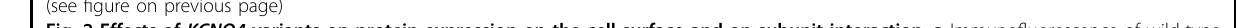
Fig. 2 Effects of KCNQ4 variants on protein expression on the cell surface and on subunit interaction. a Immuno fl uorescence of wild-type (WT) and variant KCNQ4 proteins in HEK 293 cells. Cells were immunostained with anti-Myc, anti-BiP, and anti-GOLGB1 antibodies. Nuclei were stained with DAPI. BiP and GOLGB1 indicate the endoplasmic reticulum and Golgi apparatus, respectively. All KCNQ4 variant proteins were observed on the plasma membrane. b Cell surface biotinylation. Proteins on the plasma membrane were labeled with biotin, isolated with avidin beads, and assessed by western blotting. Surface expression of KCNQ4 variant proteins was similar to that of the WT protein. c Coimmunoprecipitation. Cells were cotransfected with FLAG-tagged WT KCNQ4 and Myc-tagged WT or mutant KCNQ4 clones. After transfection (36 h), whole-cell lysates were subjected to immunoprecipitation using anti-FLAG beads and immunoblotted. All KCNQ4 variant proteins interacted with the WT